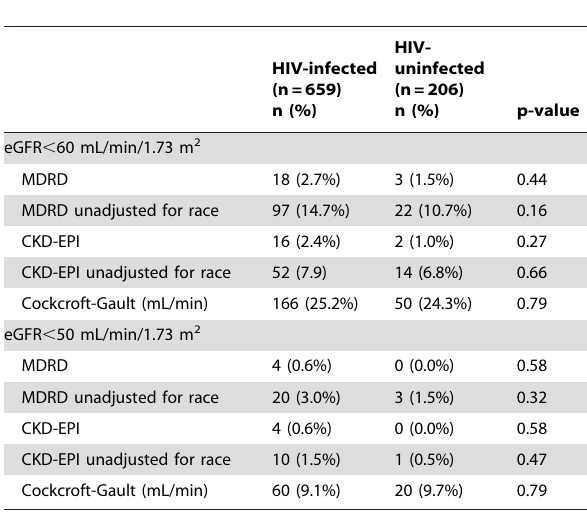
Table 2. Prevalence of decreased glomerular filtration rate stratified by HIV status and estimating